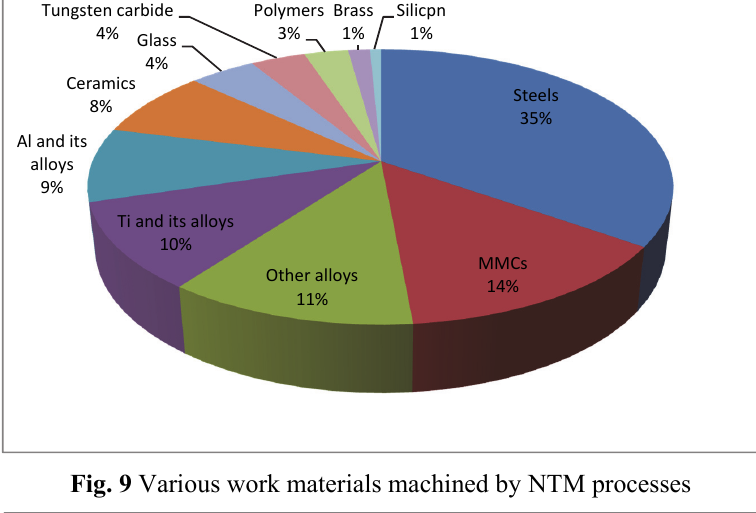
Fig. 7 Year-wise publication of research papers on para- metric optimization of NTM processes